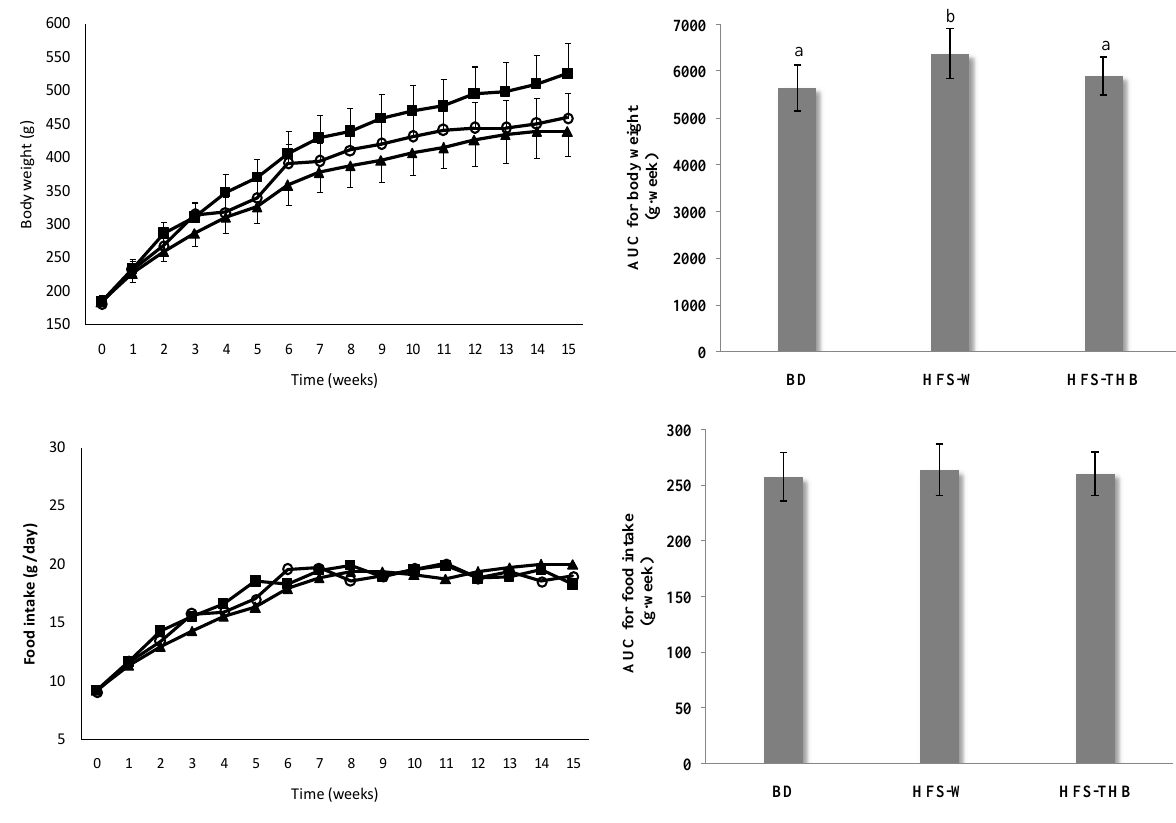
Figure 1. Body weight and food intake during the 15-week study. (▲) Basal diet intake group (BD); ( ■ ) High-fat-sucrose diet with refined wheat intake group (HFS-W); (○) High-fat-sucrose diet combined with whole Tibetan hull-less barley intake group (HFS-THB). Samples were analyzed using a one-way ANOVA followed by a Turkey post doc test. Evaluations were taken among three groups, a, b indicate statistical differences ( P < 0.05), the same letters indicate no statistical differences ( P >